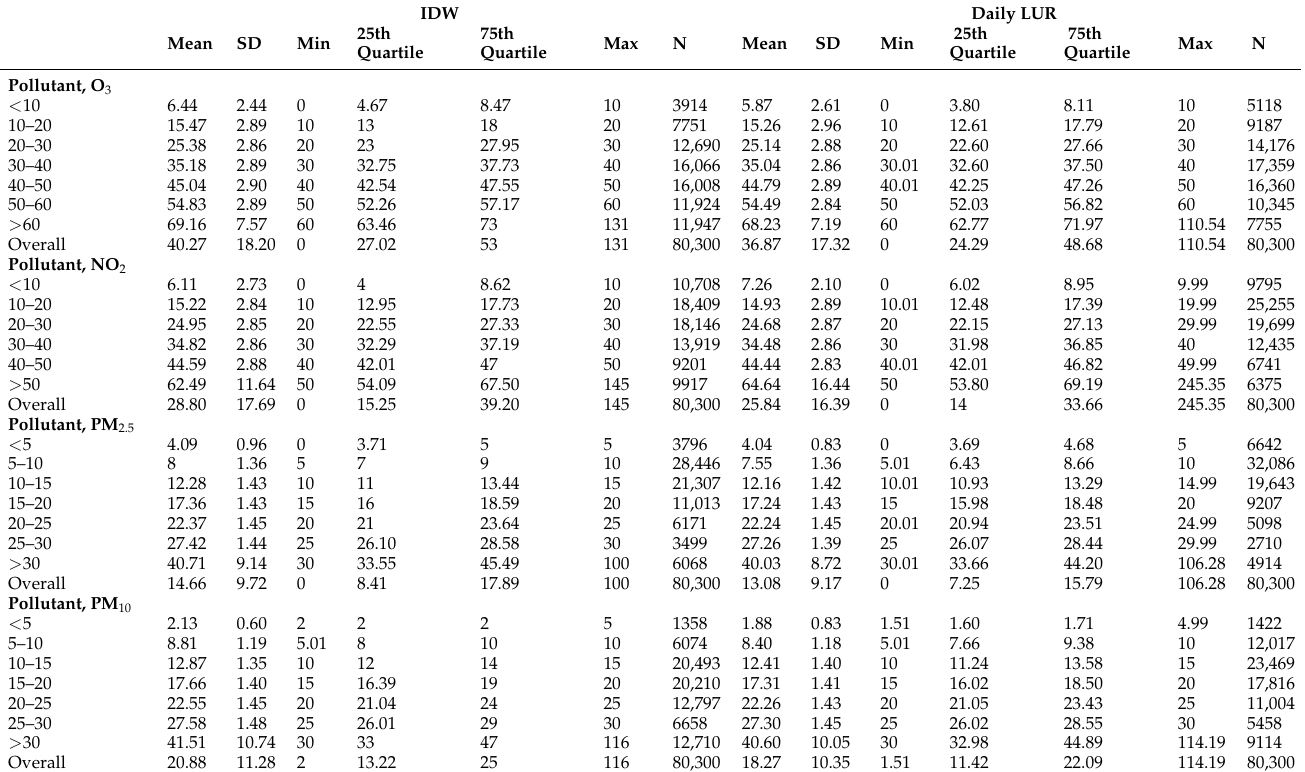
Table A2. Summary statistics of each air pollutant (in µg/m 3 ) across the various pollution bins